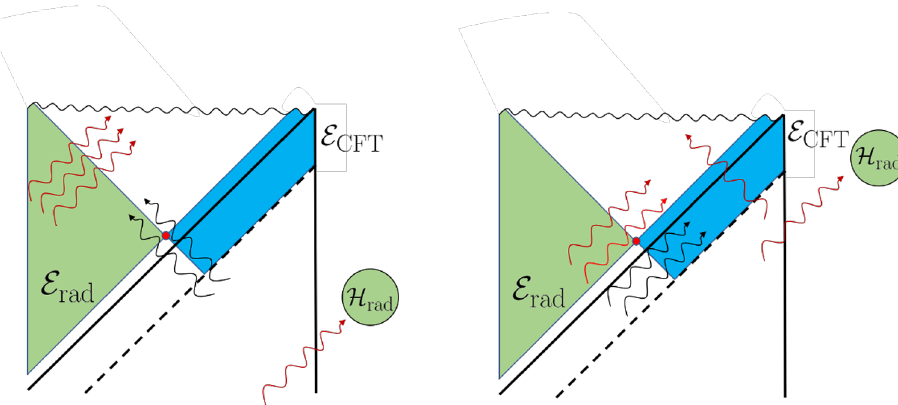
Figure 10. In the left (cid:12)gure, infalling modes near the quantum extremal surface are in a infalling- time-translation invariant mixed state. These mixed state modes (black) are puri(cid:12)ed by modes deep in the interior, together with modes that escaped into the reservoir (both red). Both of these are in the entanglement wedge of the reservoir H rad . In the right (cid:12)gure, outgoing modes near the quantum extremal surface (black) are entangled with outgoing modes in the interior, but also with outgoing modes that recently escaped into the reservoir and late-time infalling modes that were re(cid:13)ected back into the black hole (all in red). The (cid:12)rst two are in the entanglement wedge of H rad , while the last is in the entanglement wedge of the CFT. The bulk entropy of the modes in the entanglement wedge of the CFT depends on U no longer depends on U in the same simple way that it did when no greybody factors were present in section